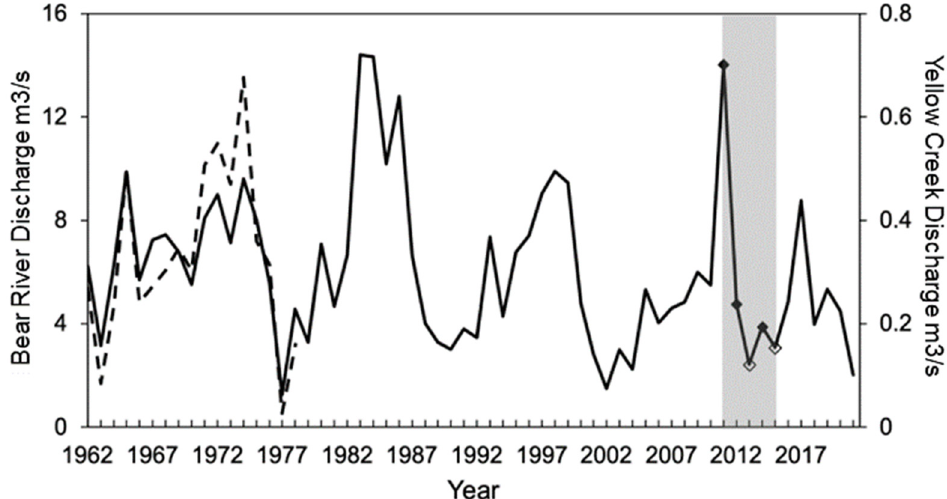
Figure 2. Average daily discharge data for both Yellow Creek and the Bear River. Comparison of the data shows the association between the flow of both systems. No data were available for Yellow Creek within the years of our study; thus, the Bear River is used as proxy. Yellow Creek is represented by the dashed line and the Bear River by the solid line. Years with perennial flow are marked with a solid diamond and years with intermittent flow are marked by an open diamond. Scale for Yellow Creek is represented on the right and the Bear River on the left. Years within our study are highlighted with a gray background. Yellow Creek Gauge: USGS 10017000. Bear River Gauge: USGS 10020300. While Yellow Creek flow patterns have been quite variable, this stream has had perennial (year-round) flow over the past few decades (personal communication, Kyle Lowham); intermittence is a new phenomenon that occurred in 2013 and 2015 in the study section.